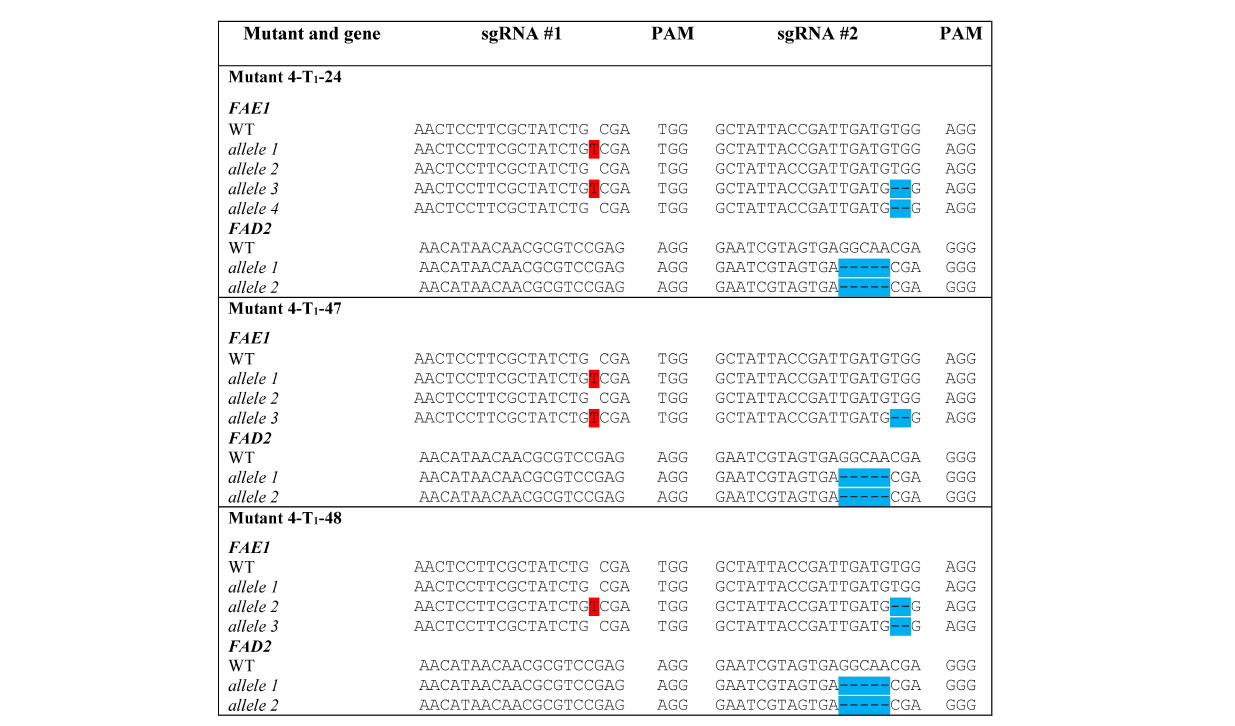
C18:1 level and reduced PUFA contents (Figure 7). The C18:1 level was signi fi cantly increased to 22.5% compared with 13.3% in the wild type, while the C18:3 and C18:2 contents were signi fi cantly reduced from 38.4% in the wild type to 29.9% in the mutant and from 8.8% in the wild type to 7.5% in the mutant, respectively.